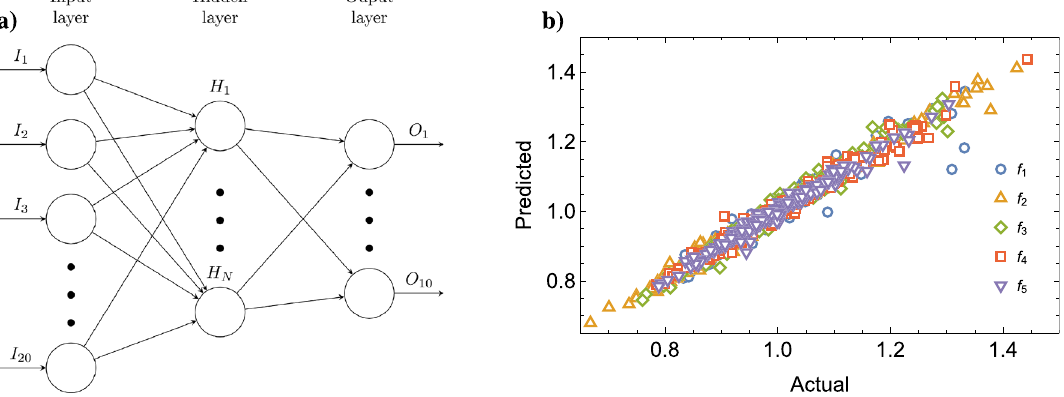
Figure 2. ( a ) Architecture used for prediction. ( b ) Predicted versus actual values for the first five eigenfrequencies in the test set for a network with N = 7 . The frequencies are scaled by the average actual values for each mode in order to be able to compare different frequency values in the same plot. The prediction turns out to produce R 2 = 0.977 .